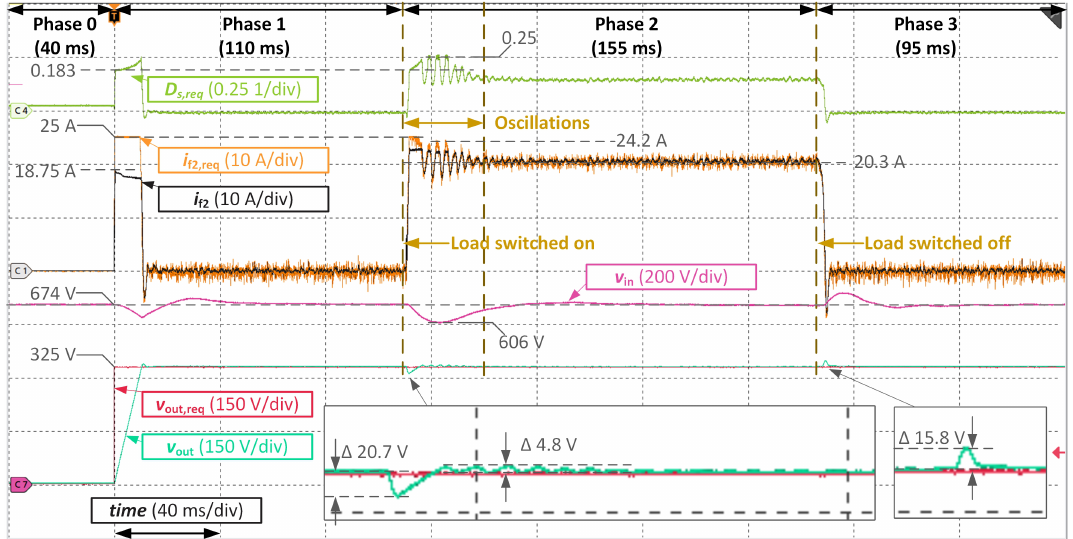
Figure 17. Experimental results for controllers tuned according to parameters (Equations(Equations (31)–(33)) and Equa- tions (48) and (49): reference voltage value for the active rectifier v in,ref = 670 V, reference output voltage value for the DAB converter v out,ref = 325 V, additional current limitation I spec = 25 A, resistive load R = 16 Ω